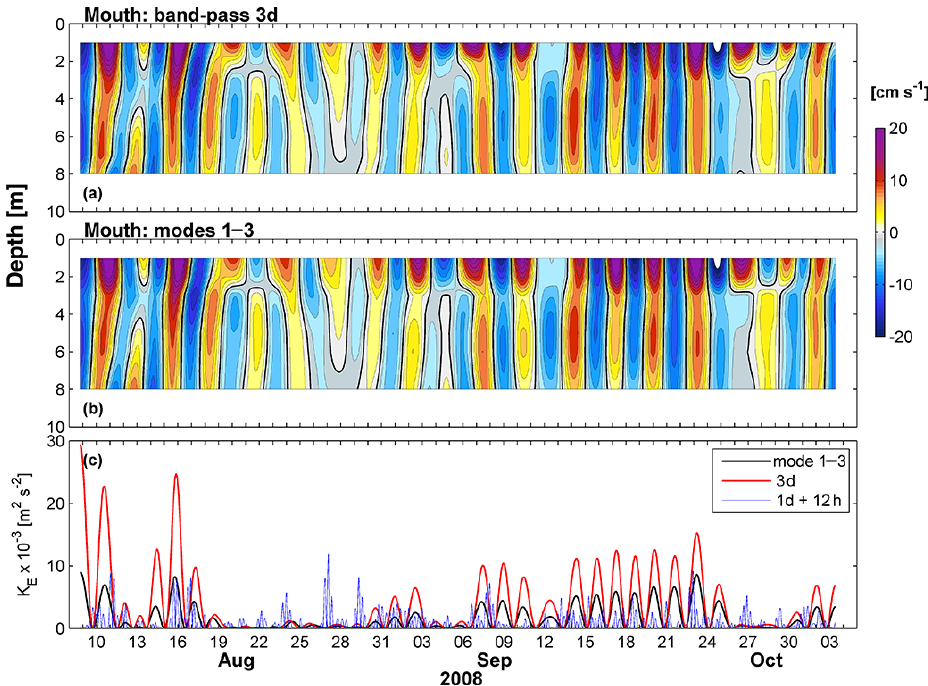
Figure 7. (a) Reconstruction of the along-fjord band-passed currents at the mouth using modes 1–3, (b) band-passed along-fjord currents at the mouth, (c) kinetic energy ( K E ) estimated using reconstructed currents (black), the 3-day band-pass currents (red), and the diurnal and semi-diurnal band-pass currents